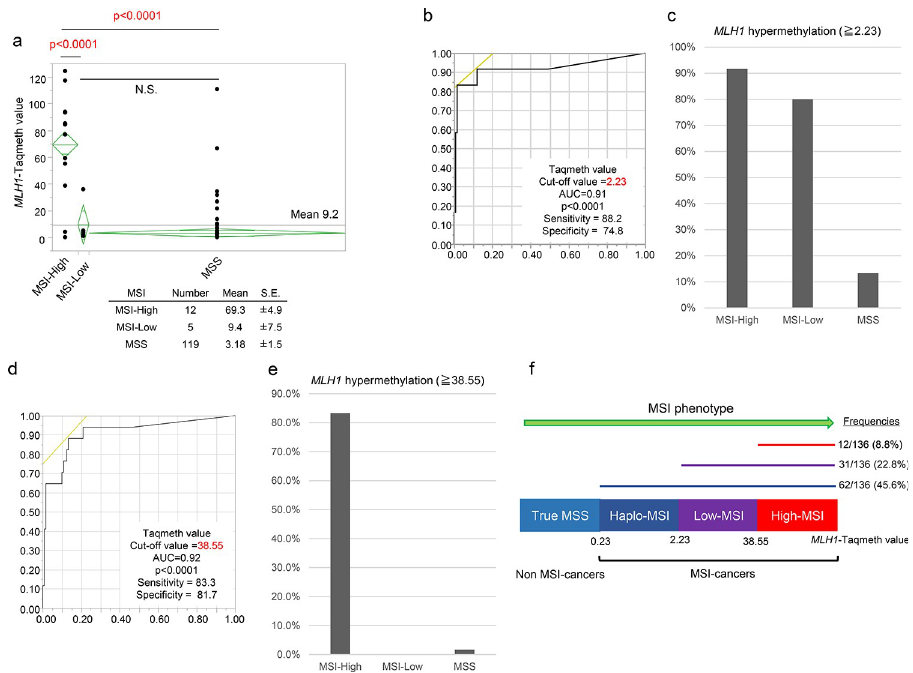
Fig 5. (a) MLH1 TaqMeth value distribution in the gastric cancer tissues according to three groups of microsatellite instability (MSI) (MSI-High, MSI-Low, Microsatellite stable; MSS). (b) Receiver operating characteristics (ROC) of the optimal cutoff value of MLH1 TaqMeth value in MSI-High and Low. (c) Percentage of MSI-High, MSI-Low, MSS equal to or over MLH1 TaqMeth value 2.23. (d) ROC of the optimal cutoff value of MLH1 TaqMeth value in MSI-High. (e) Percentage of MSI-High, MSI-Low, MSS equal to or over MLH1 TaqMeth value 38.55. (f) The four kinds of MSI phenotype (MSI-H, MSI-L, and haploinsufficiency of MSI; MSI-haplo, MSS) which could be delineated by MLH1 methylation values. Optimal cut off value of MLH1 TaqMeth value and its frequency for each MSI phenotype.